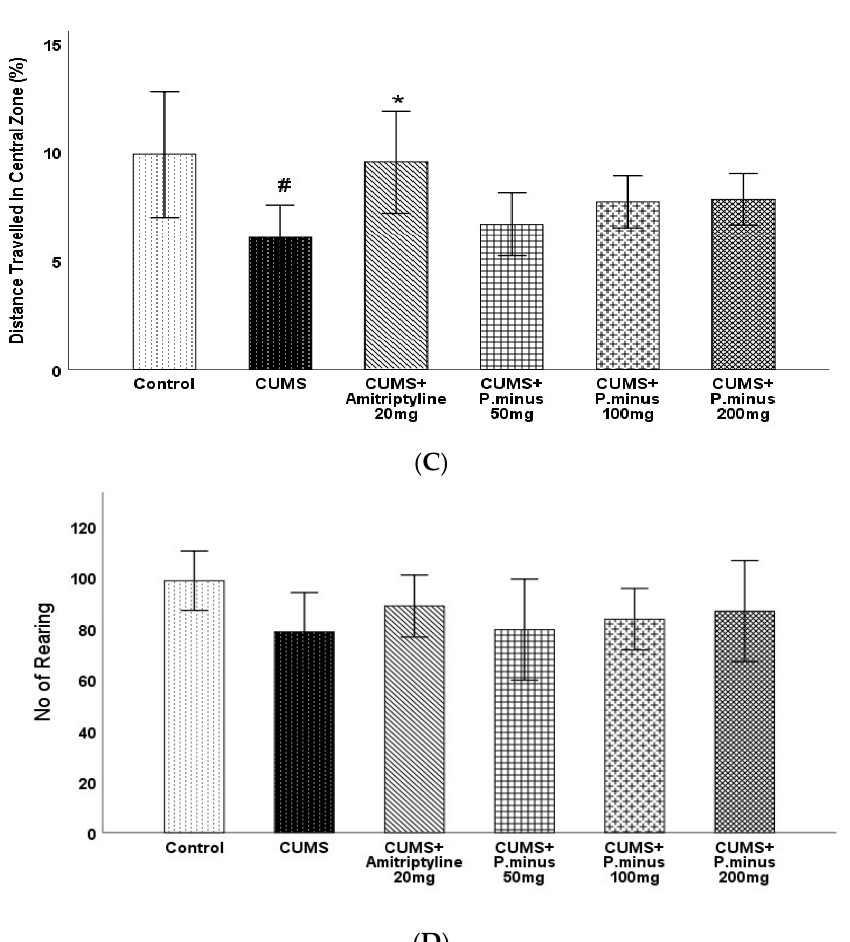
Figure 4. Effects of P. minus aqueous extract on Open Field Test in CUMS induced depressive mice. ( A ) Total distance travelled (cm), ( B ) Time spent in central zone (%), ( C ) Distance travelled in central zone. ( D ). No of rearing # ( p < 0.05), vs. Control group; * ( p < 0.05), vs. CUMS group. ( n = 14).